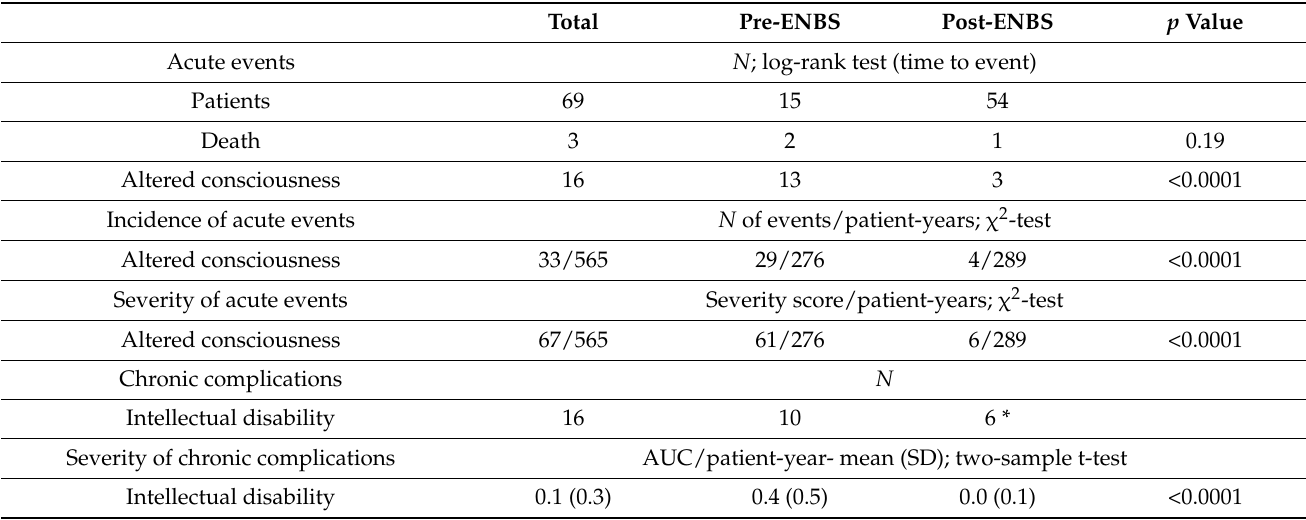
Table 3. Acute and chronic complications and their severity in patients diagnosed with MCADD before and after ENBS.